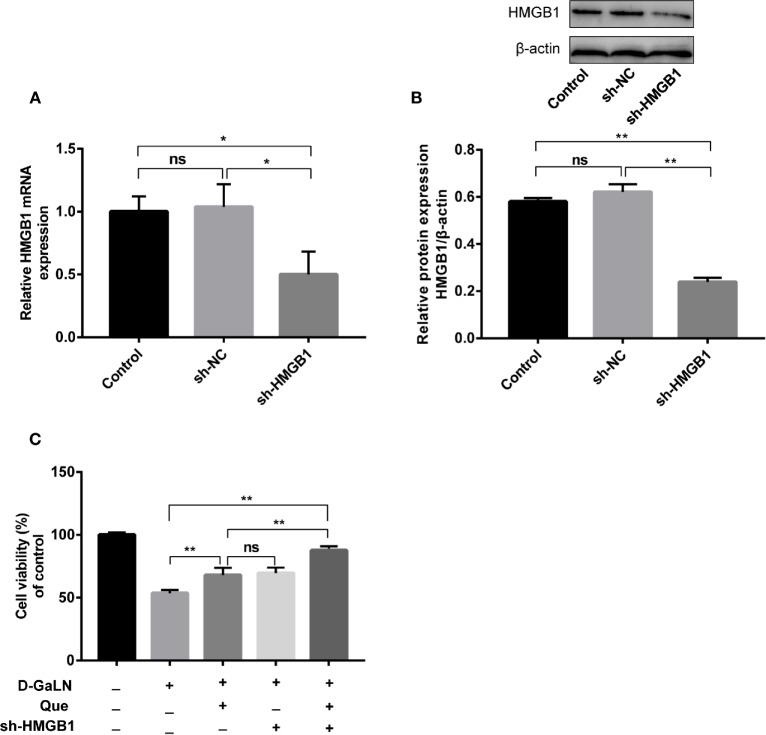
The effect of Que on the viability of L02 cells after silenced HMGB1. The sh-HMGB1 was transfected into L02 cells, and its transfection efficiency was confirmed at (A) the mRNA level, by qRT-PCR; (B) and the protein level, by Western blot assay; (C) after silenced HMGB1, the CCK8 assay was used to analyze the cell viability of L02 cells under different exposure conditions. Data are presented as the mean ± SD (*p < 0.05, **p < 0.01, n = 3); “ns” indicates not significant (p > 0.05).